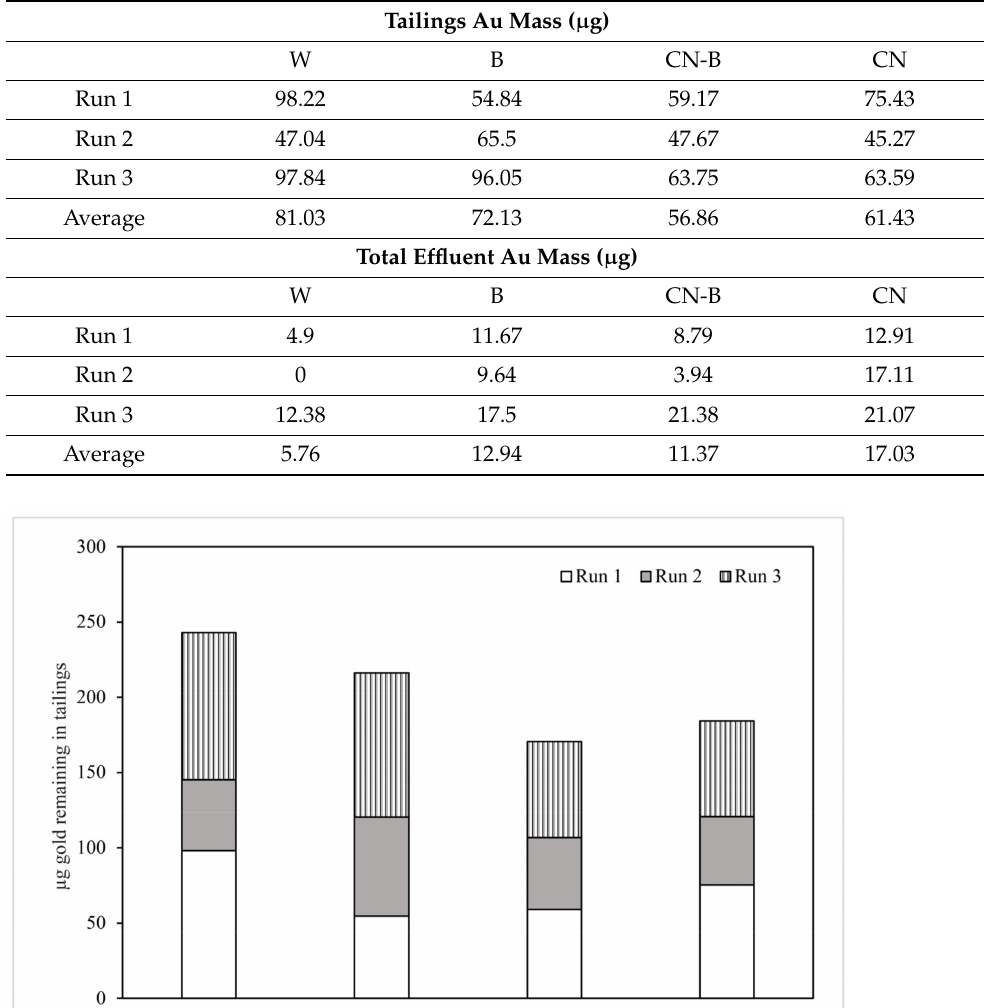
Table 2. Average Au mass recovered from tailings and effluents in experimental Runs 1, 2 and 3.